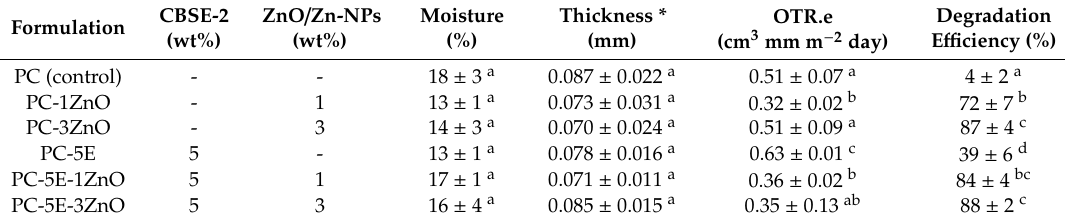
Table 1. Moisture, thickness, barrier properties and photocatalytic activity of pectin-based films.